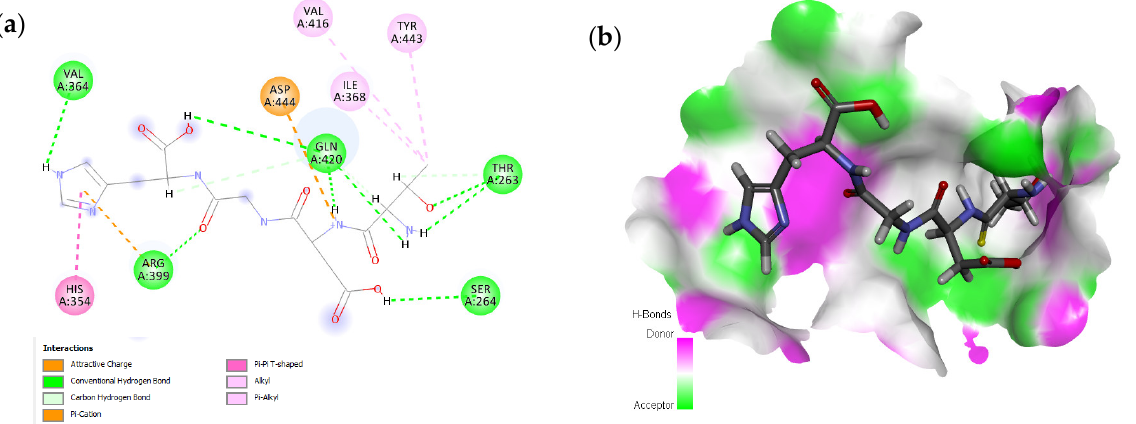
Figure 2. Interaction ( a ) and binding pattern ( b ) of TDGH peptide with ORF2 (capsid protein) with HEV as receptor.